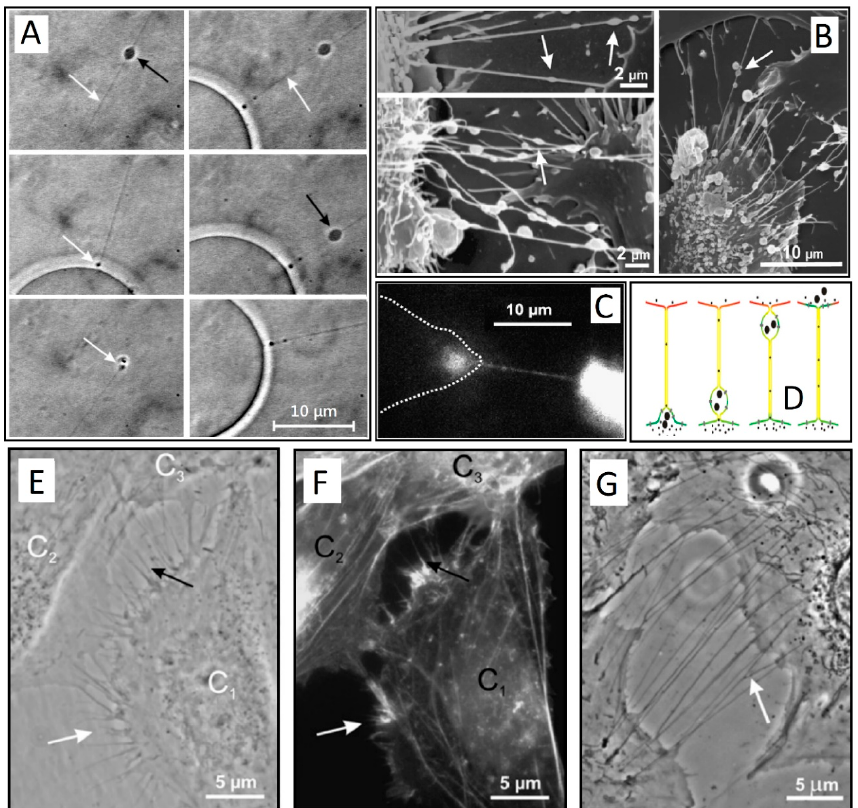
Figure 1. ( A ) Snapshots of a small gondola (black arrow) traveling along the thin phospholipid tube (white arrow) attached to a spherical giant unilamellar vesicle (GUV). In the final stage, the traveling gondola fused with the membrane of the GUV (white arrow) (adapted from Reference [2]). ( B ) Scanning electron microscopy of membrane nanotubes with gondolas (white arrows) observed between cells in the human urothelial cell line under physiological conditions (adapted from Reference [11]). ( C ) Exchange of actin-GFP via a TNT between two T24 cells (cell borders are indicated by a dashed line) (adapted from [11]). ( D ) A schematic illustration of TNT-directed transport between cells. Note that the gondola is the integral part of the membrane (adapted from Reference [2] and Reference [11]). ( E, G ) A phase contrast image of live T24 cells with type I TNTs (adapted from Reference [11]). ( F ) Fluorescence micrograph showing actin labeling of the same cells as in E after 15 min of paraformaldehyde fixation. Cell C 1 is approaching the cells C 2 and C 3 . The white arrows in ( E , F ) indicate short and dynamic membrane protrusion with which the approaching cell explores its surroundings. The black arrow in ( E ) points at protrusions that have already connected to the target cell. In all these multiple tubular connections, actin filaments are present (arrows in ( F )). Bridging type I TNTs can be more than 20 µ m in length (arrow in ( G )) (adapted from Reference